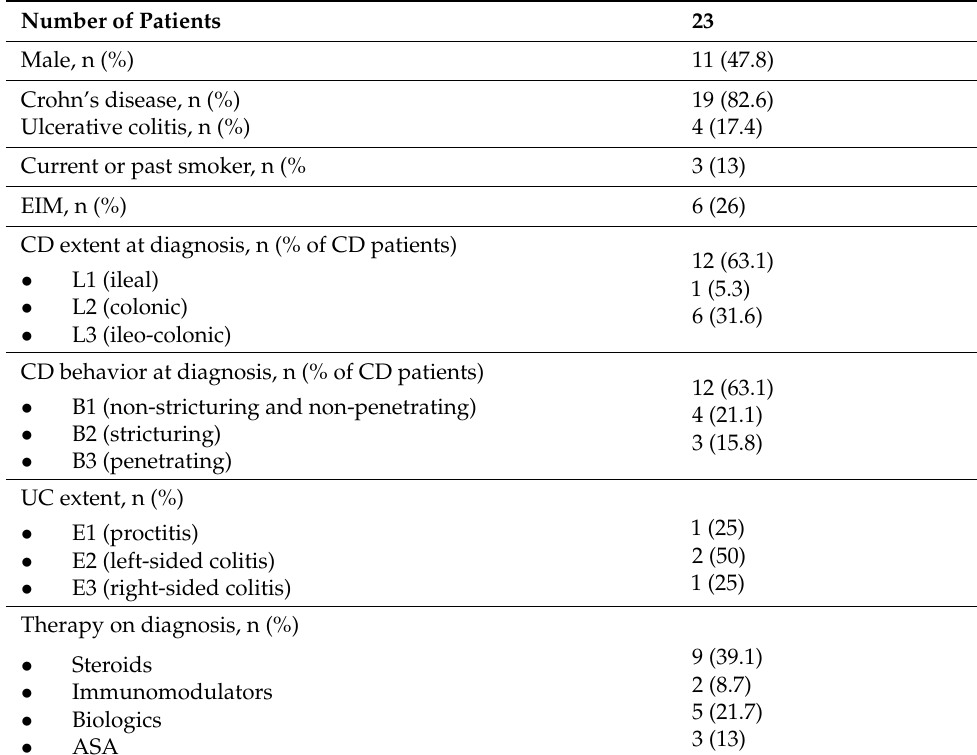
Table 2. IBD characteristics of patients.